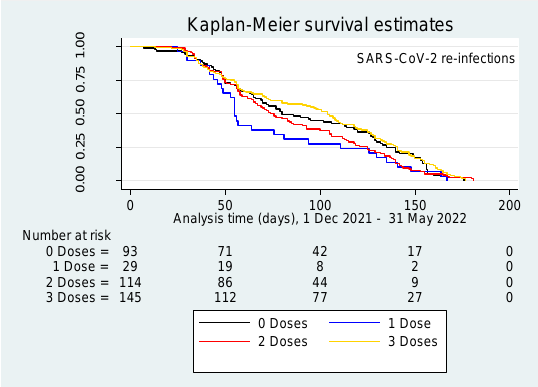
Figure 5. (Kaplan-Meier survival curve). SARS-CoV-2 re-infections ( N = 386) in healthcare workers of ASUGI between 1 December 2021 – 31 May 2022, by number of doses of COVID-19 vaccines received 7+ days (14+ days in case of only one dose) before re-infection. Number of HCWs at risk by number of doses of COVID-19 vaccine received.